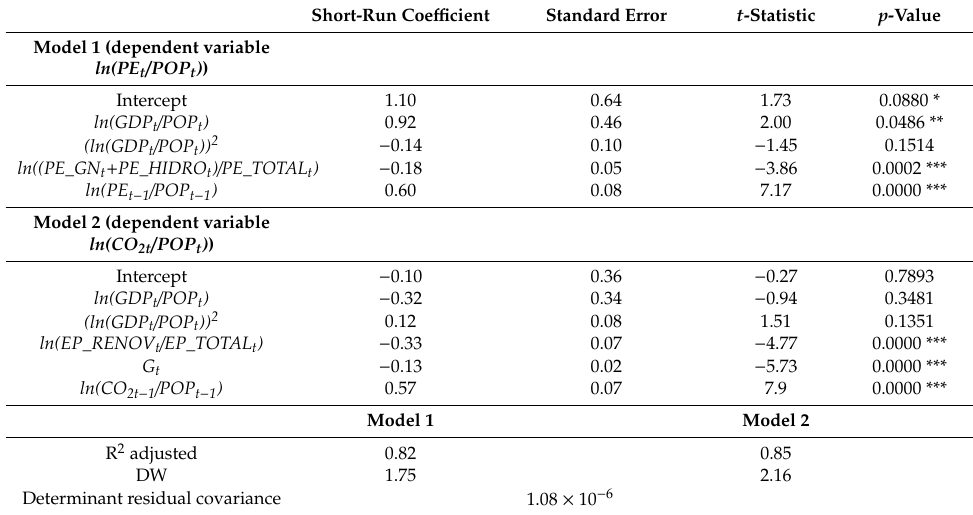
Table 1. Short-run estimates of models 1 and